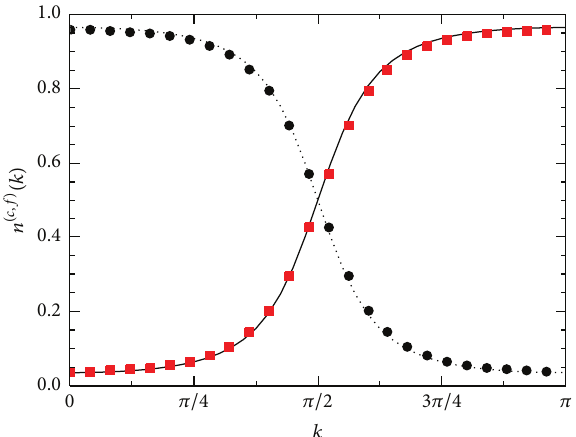
= 𝑈 = 0 , 𝑉/𝑊 = 0.1 , 𝑓 𝑐𝑓